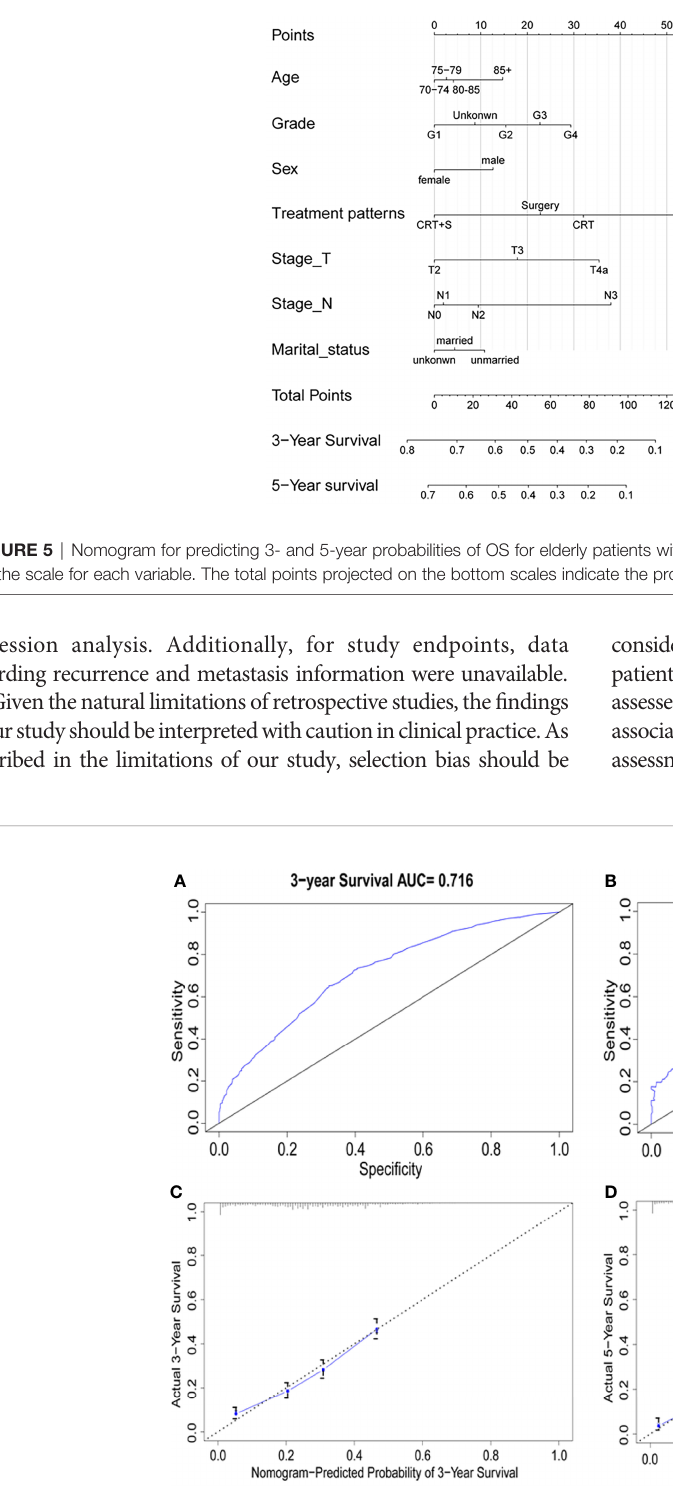
FIGURE 6 | Comparison of the AUCs and Calibration curves for the nomogram. (A, B) Area under the curves of the two models to predict overall survival at 3 years (A) and 5 years (B) , (C, D) Calibration curves for the nomogram at 3 years (C) and 5 years (D) , the x axis represents the nomogram-predicted survival rate, whereas the y axis represents the actual survival